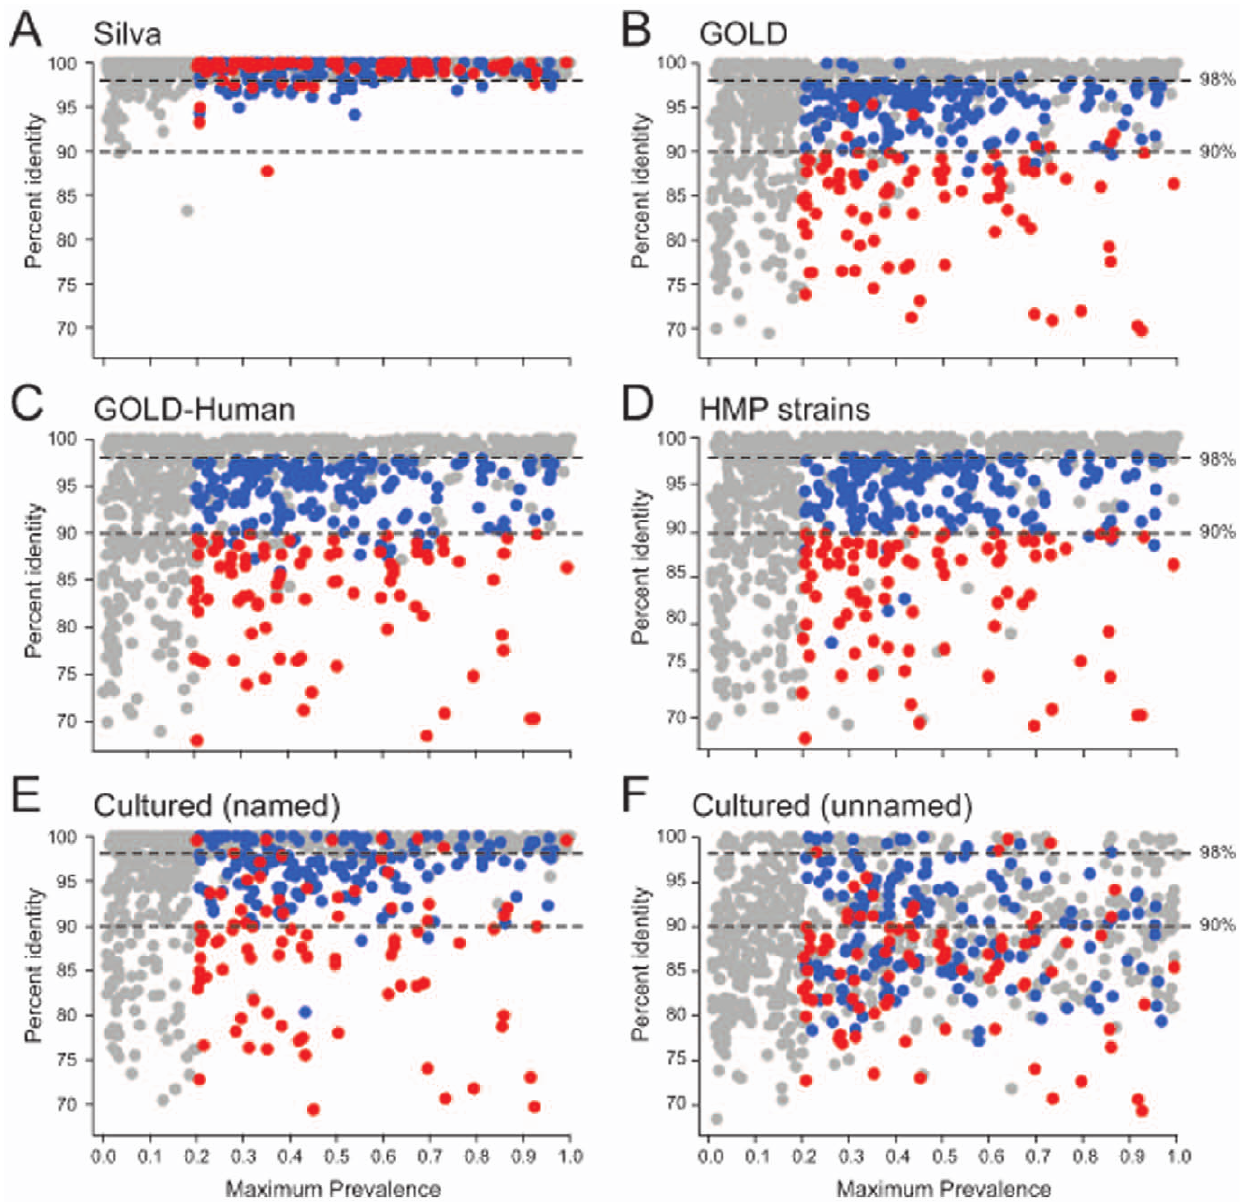
Figure 3. There were few novel, but many uncultured and unsequenced taxa within the HMP OTUs. Panels A through F present results from aligning HMP OTUs to six separate 16S sequence databases, indicated. For each HMP OTU, the y-axis of each panel shows the percent identity for the best matching sequence from the queried database, as determined by the program align.seqs in Mothur [30]. The x-axis of each panel shows the fraction of samples in which the OTU was present, at the body site of its highest prevalence. For example, a value of 0.5 means that the OTU was present in, at most, 50% of samples from a particular body site. The colors in all panels indicate assignment to priority groups for whole genome sequencing: red=highest priority, blue=medium priority, gray=low priority. Horizontal lines indicate 98% and 90% sequence